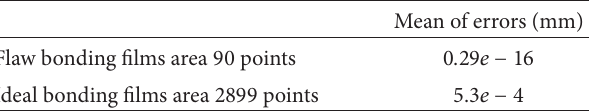
Table 5: Errors of the inversed results.